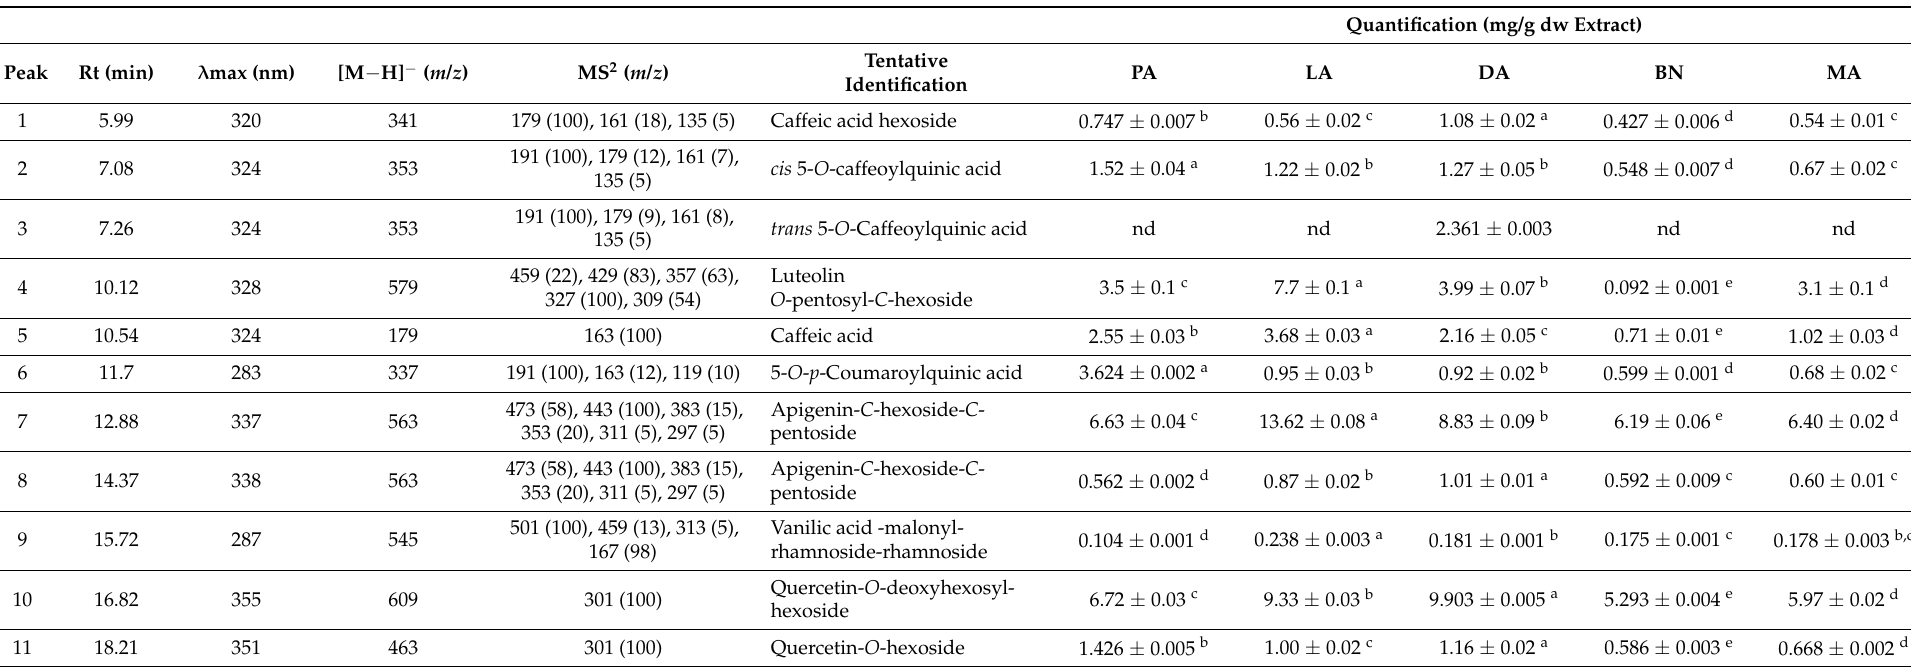
Table 6. Chromatographic identification by LC-DAD-ESI/MSn of the phenolic compounds present in fig leaves’ hydroethanolic extract (retention time (Rt), wavelengths of maximum absorption in the visible region (max), spectral mass, tentative identification, and